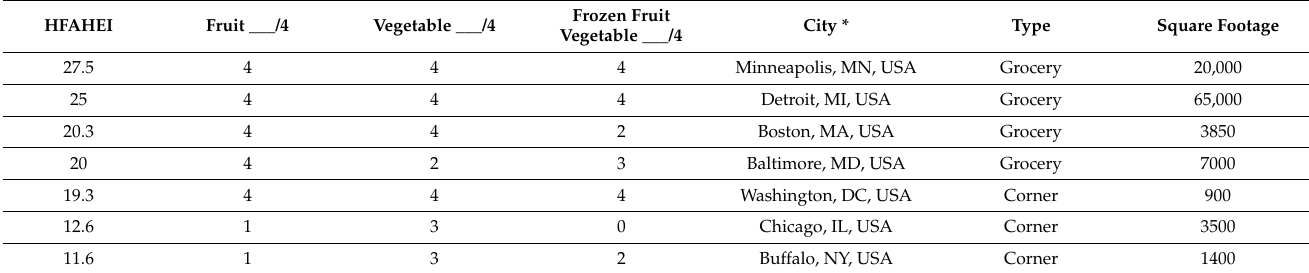
Table 3. Fruit and vegetable availability by location with HFAHEI